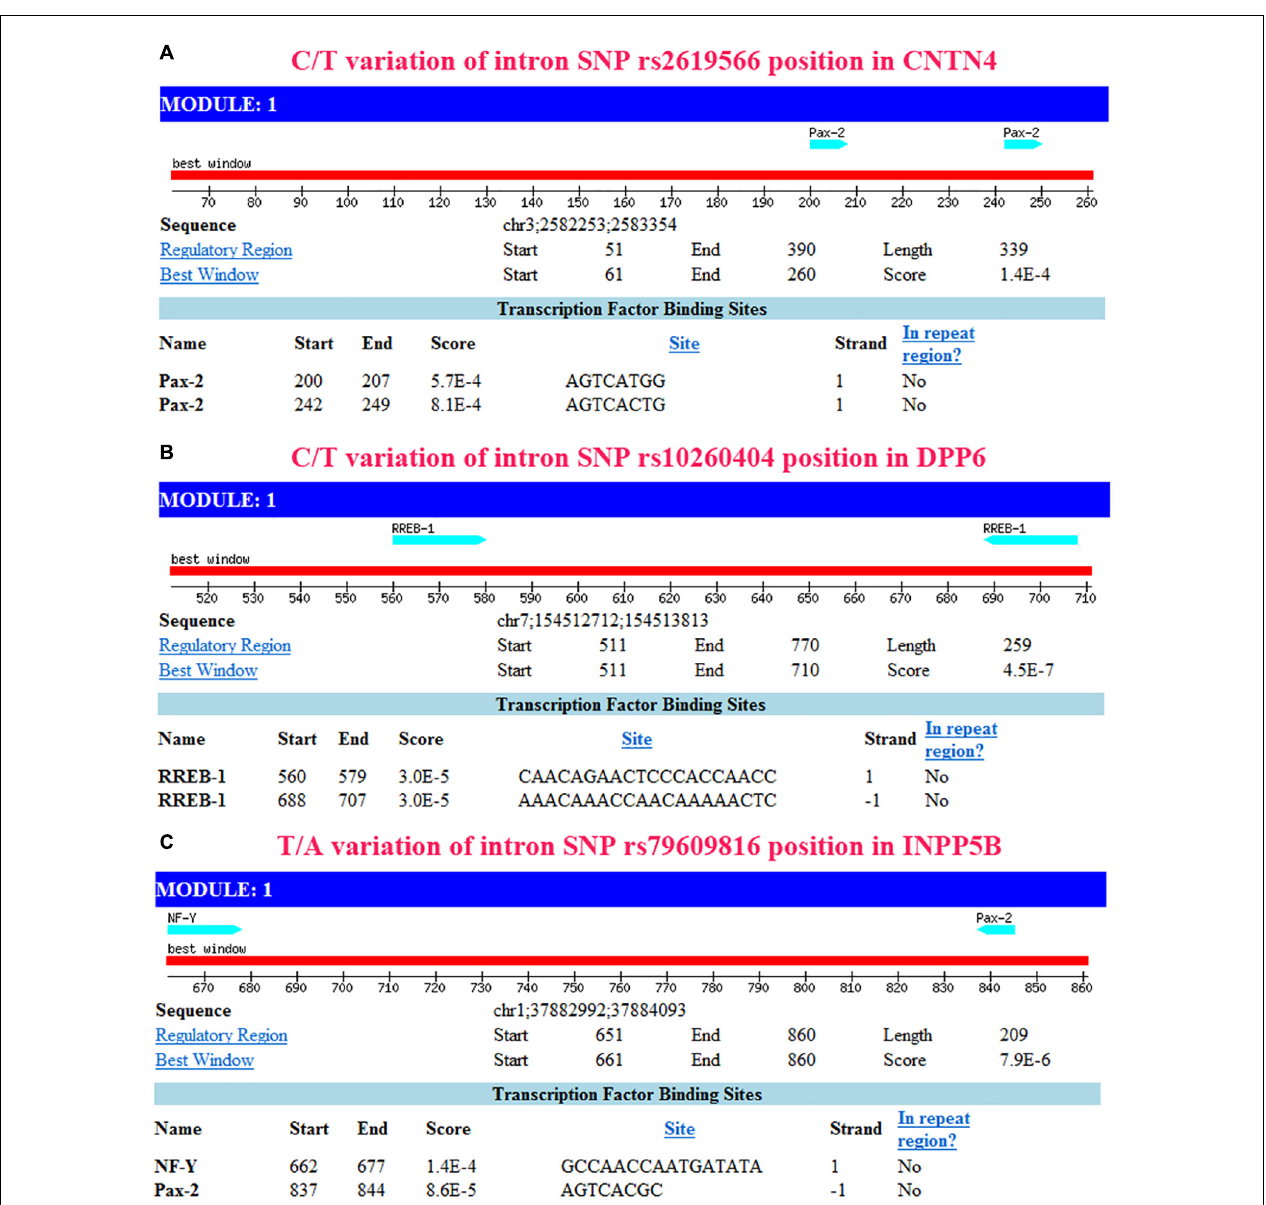
FIGURE 5 | Transcription factor prediction using Mscan. The prediction based on NHRscan and Mscan provided consistent results. (A) Transcription factor binding site located between 793 and 800 bp, and between 751 and 758 bp away from the upstream of binding site in CNTN4 . (B) Transcription factor binding site located between 440 and 421 bp, and between 312 and 293 bp away from the upstream of binding site in DPP6 . (C) Transcription factor binding site located between 338 and 323 bp, and between 163 and 156 bp away from the upstream of the binding site in the INPP5B